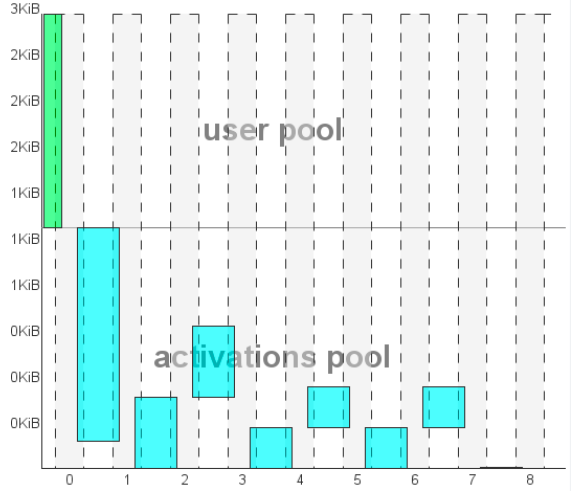
Figure 12. RAM and I/O memory usage of the sequential NN following the autoencoder.